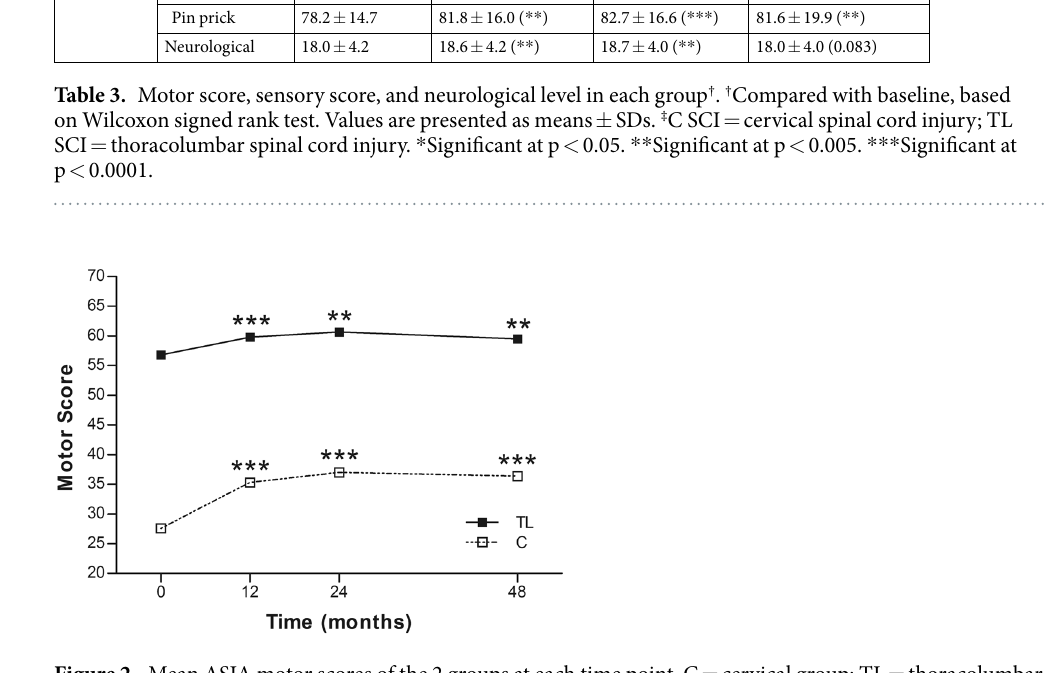
Figure 2. Mean ASIA motor scores of the 2 groups at each time point. C = cervical group; TL = thoracolumbar group; ** p < 0.005; *** p < 0.0001.